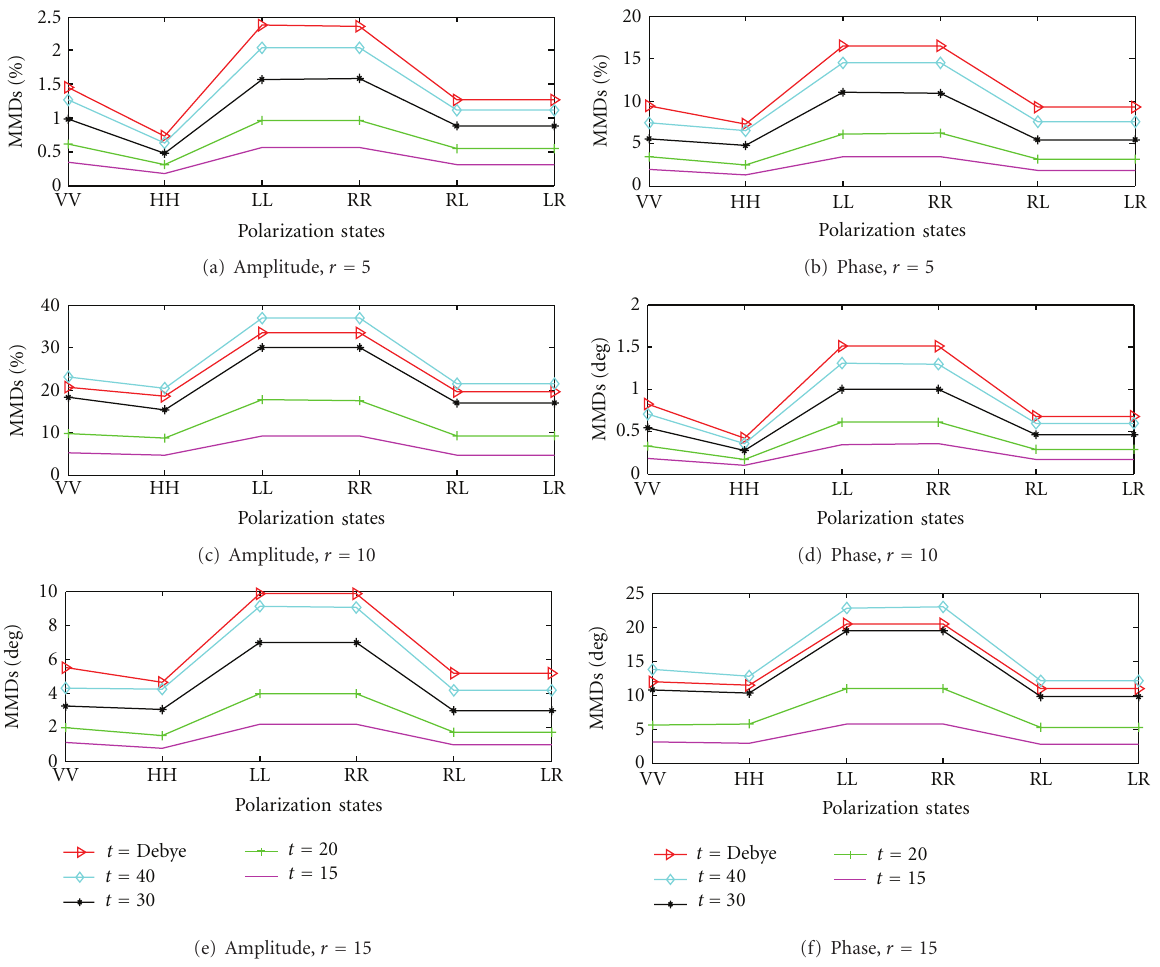
Figure 9: MMD AB for di ff erent polarization states with tumor of di ff erent sizes. In each figure, three di ff erent dielectric properties of the tumor are considered (i) Debye (Figure 3), (ii) ε r = 40, σ = 0 . 1S/m, (iii) ε r = 30, σ = 0 . 1S/m, (iv) ε r = 20, σ = 0 . 1S/m, and (v) ε r = 15, σ = 0 . 1S/m. MMD AB ,amplitude for tumor with radius of (a) 5 mm, (b) 10mm, and (c) 15 mm. MMD AB ,phase for tumor with radius of (d) 5mm, (e) 10mm, and (f)